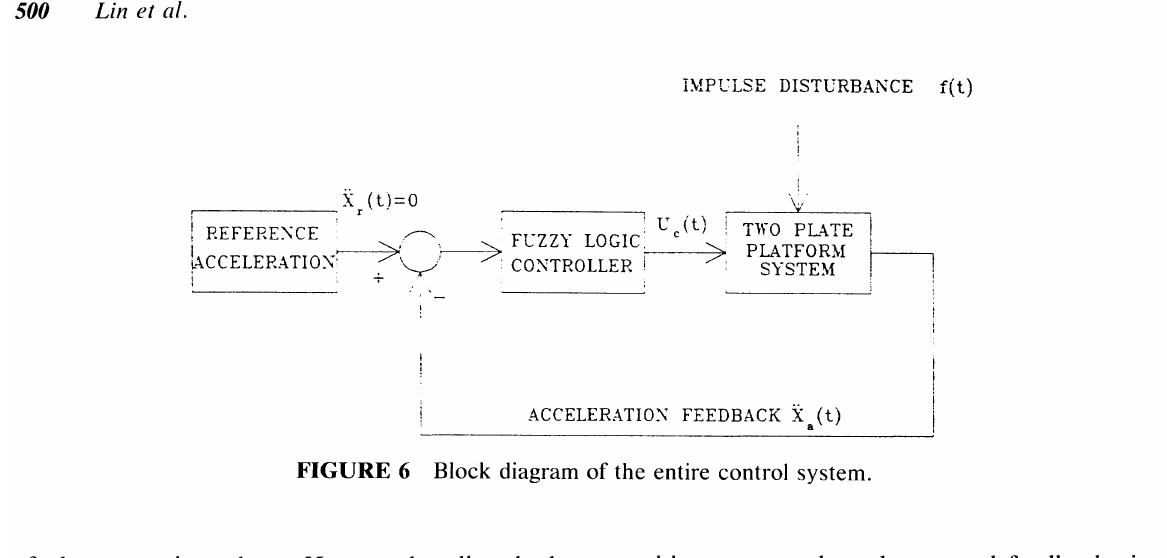
FIGURE 6 Block diagram of the entire control system.